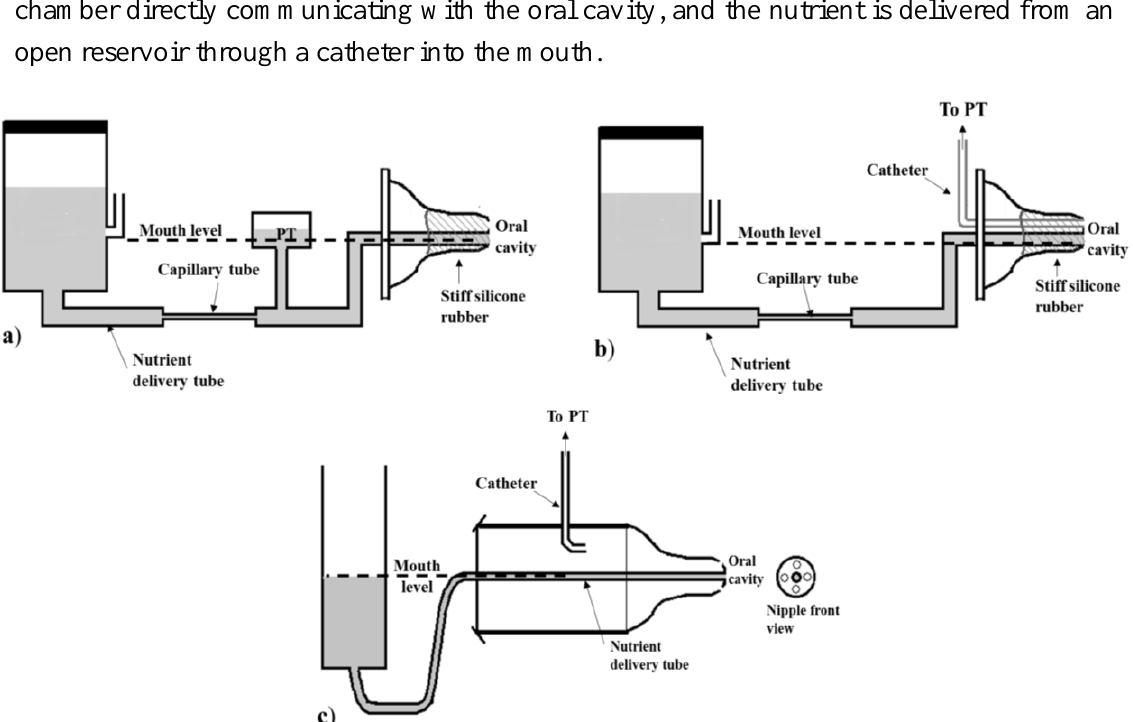
Figure 3. Schematic diagrams of feeding apparatuses designed for nutrient delivery and